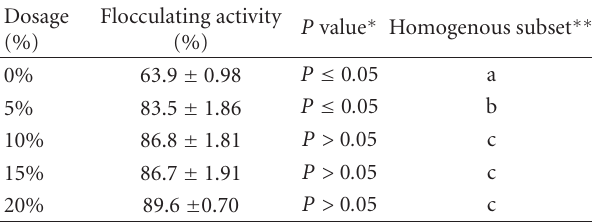
Table 4: Statistical analysis for flocculating activity at 0.1–2.0% bioflocculant